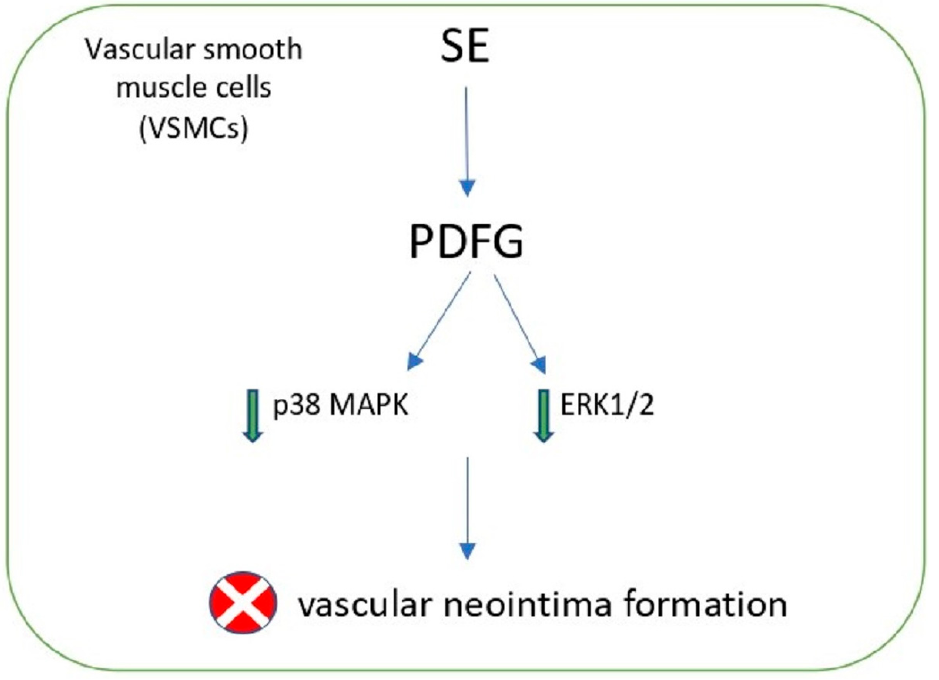
Figure 4. Neointima formation inhibition of Salicornia extract (SE) in